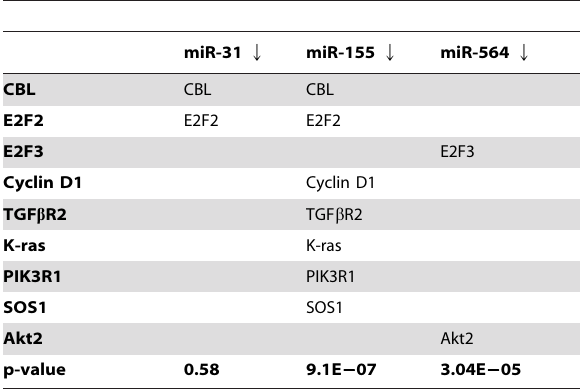
Table 3. Putative target genes of the deregulated miRNAs as predicted by Target Scan analysis.